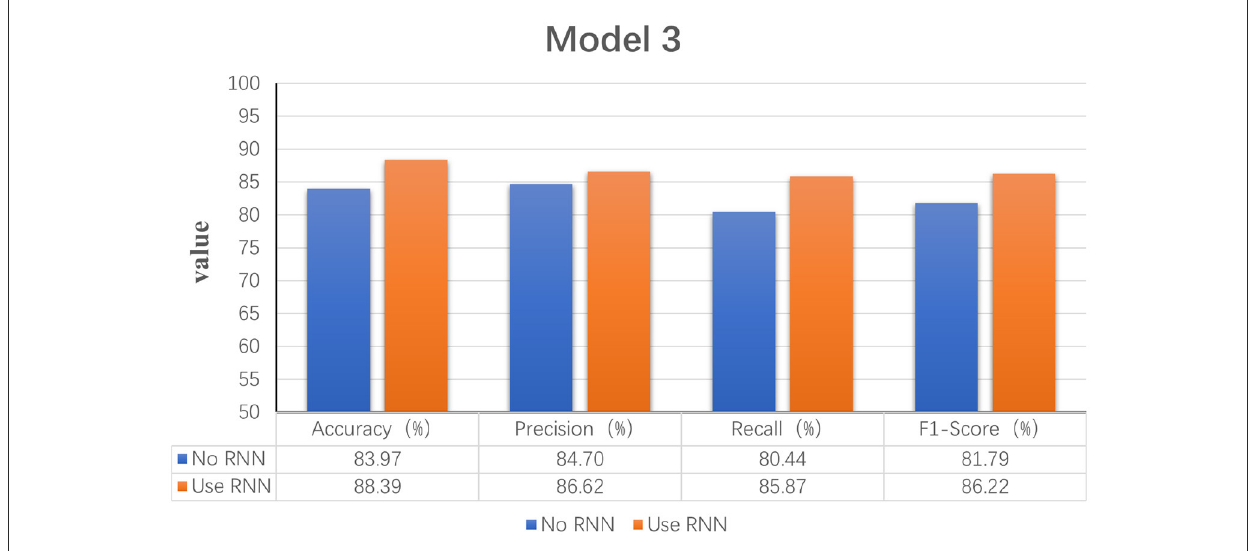
FIGURE5 Statistical graphs of the evaluation results of the model with the addition of RNN vs. without RNN.